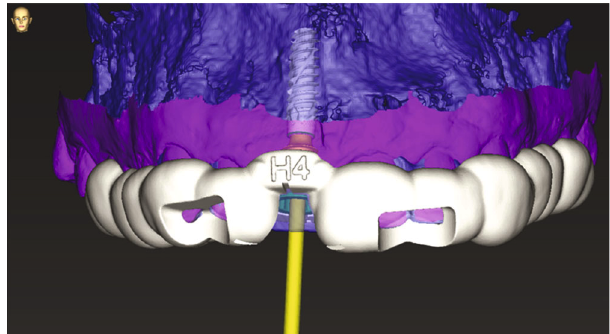
Figure 6: The buccal root “ shield ” in place after